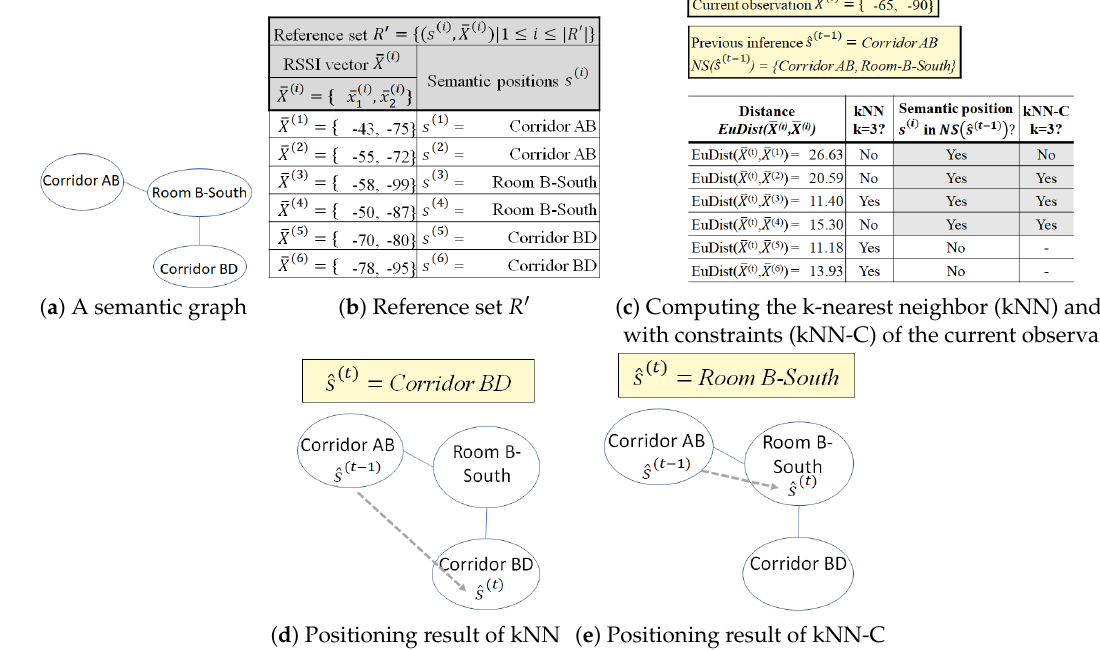
Figure 7. Effects of movement constraints on